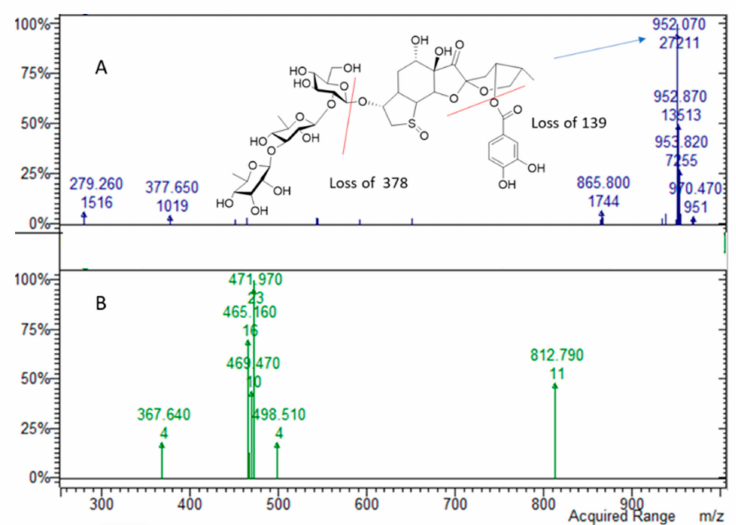
Figure6. MS(bluespectrum)andMS 2 (greenspectrum)spectrumofpeakatretentiontime52corresponding to the tentative assignment of Epibreinin B. ( A ), MS of ion 952 m / z ; ( B ), MS 2 of ion 952 m /